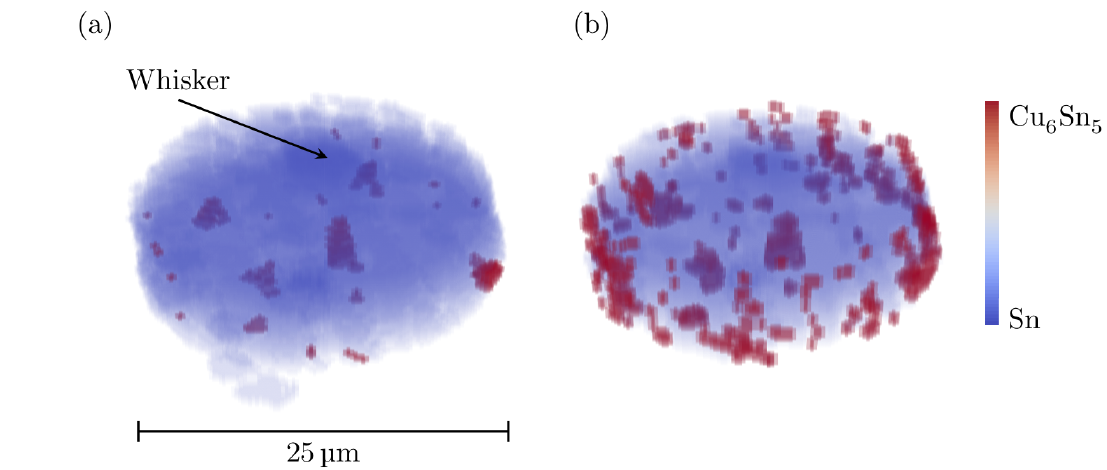
Figure 10. 3D map showing the location of Cu treatment; and ( b ) after heat treatment of 150 ◦ C for three